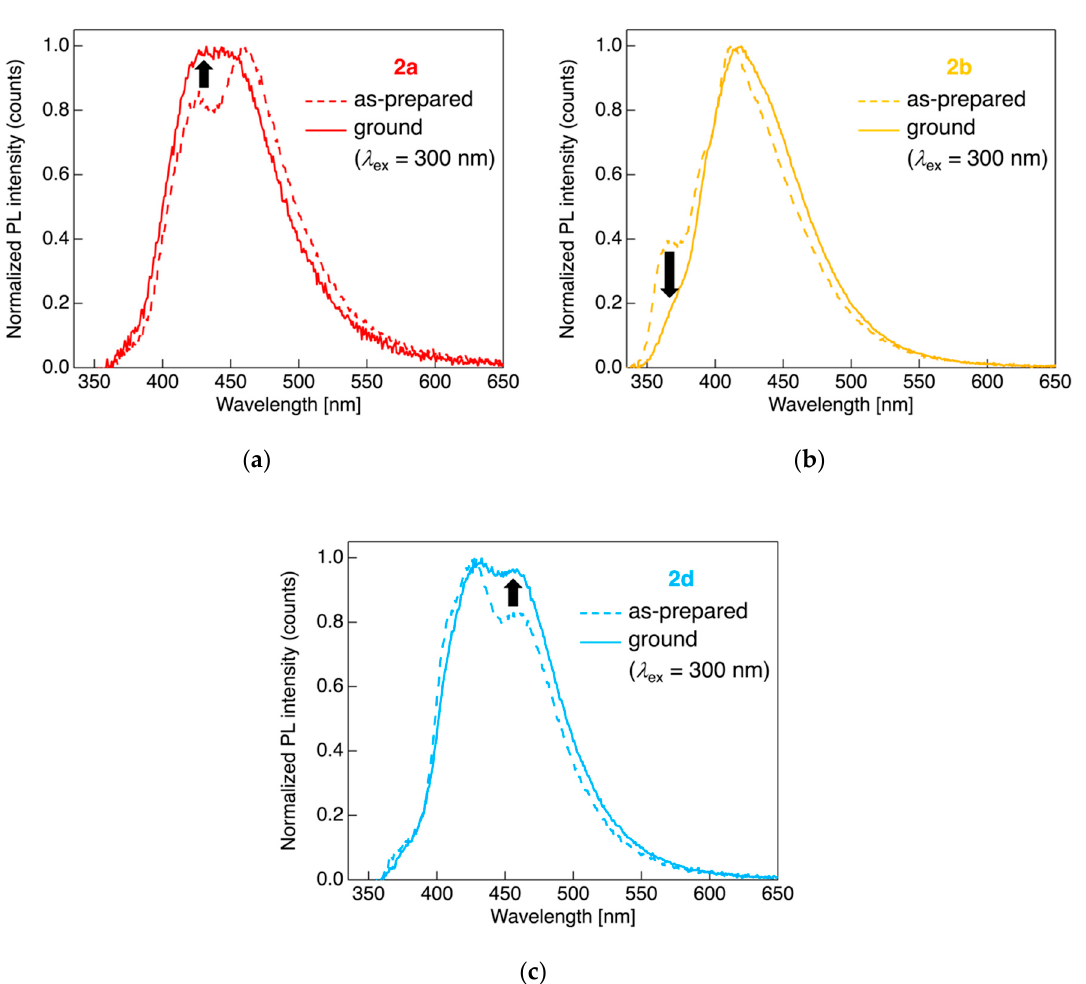
Figure 6. PL spectra of dyads ( a ) 2a , ( b ) 2b , and ( c ) 2d for the as-prepared crystalline powder sample (dashed line) and for the ground sample after applying a mechanical stimulus (solid line). Excited at 300 nm light.